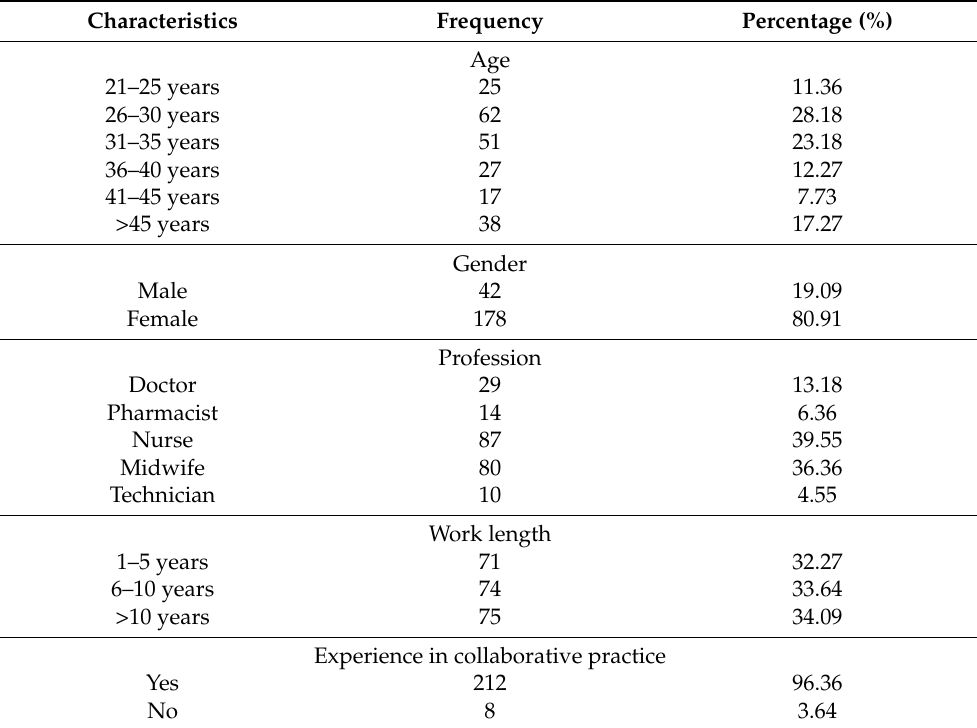
Table 1. CPAT respondent demography characteristic for Study I (N = 261 − N HUH = 98; N BRPH = 96, N HGH = 67).